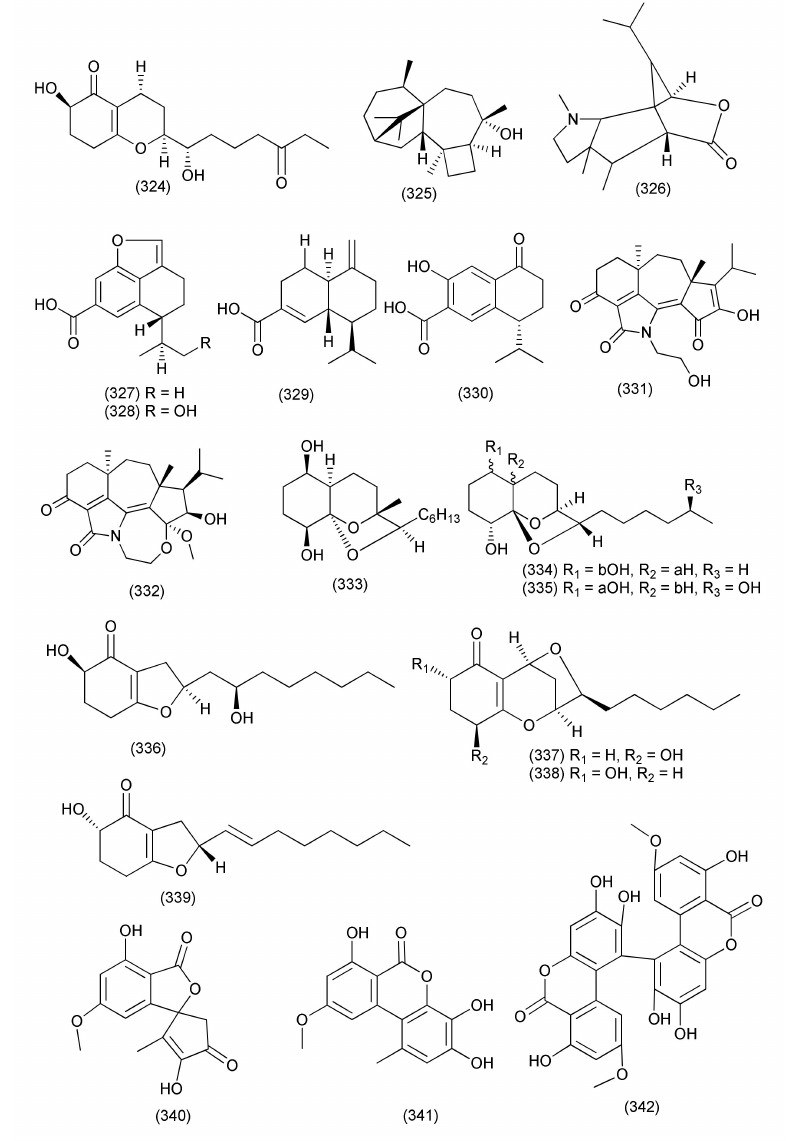
Figure 18. Structures of metabolites 324 – 342 isolated from Anamorphic